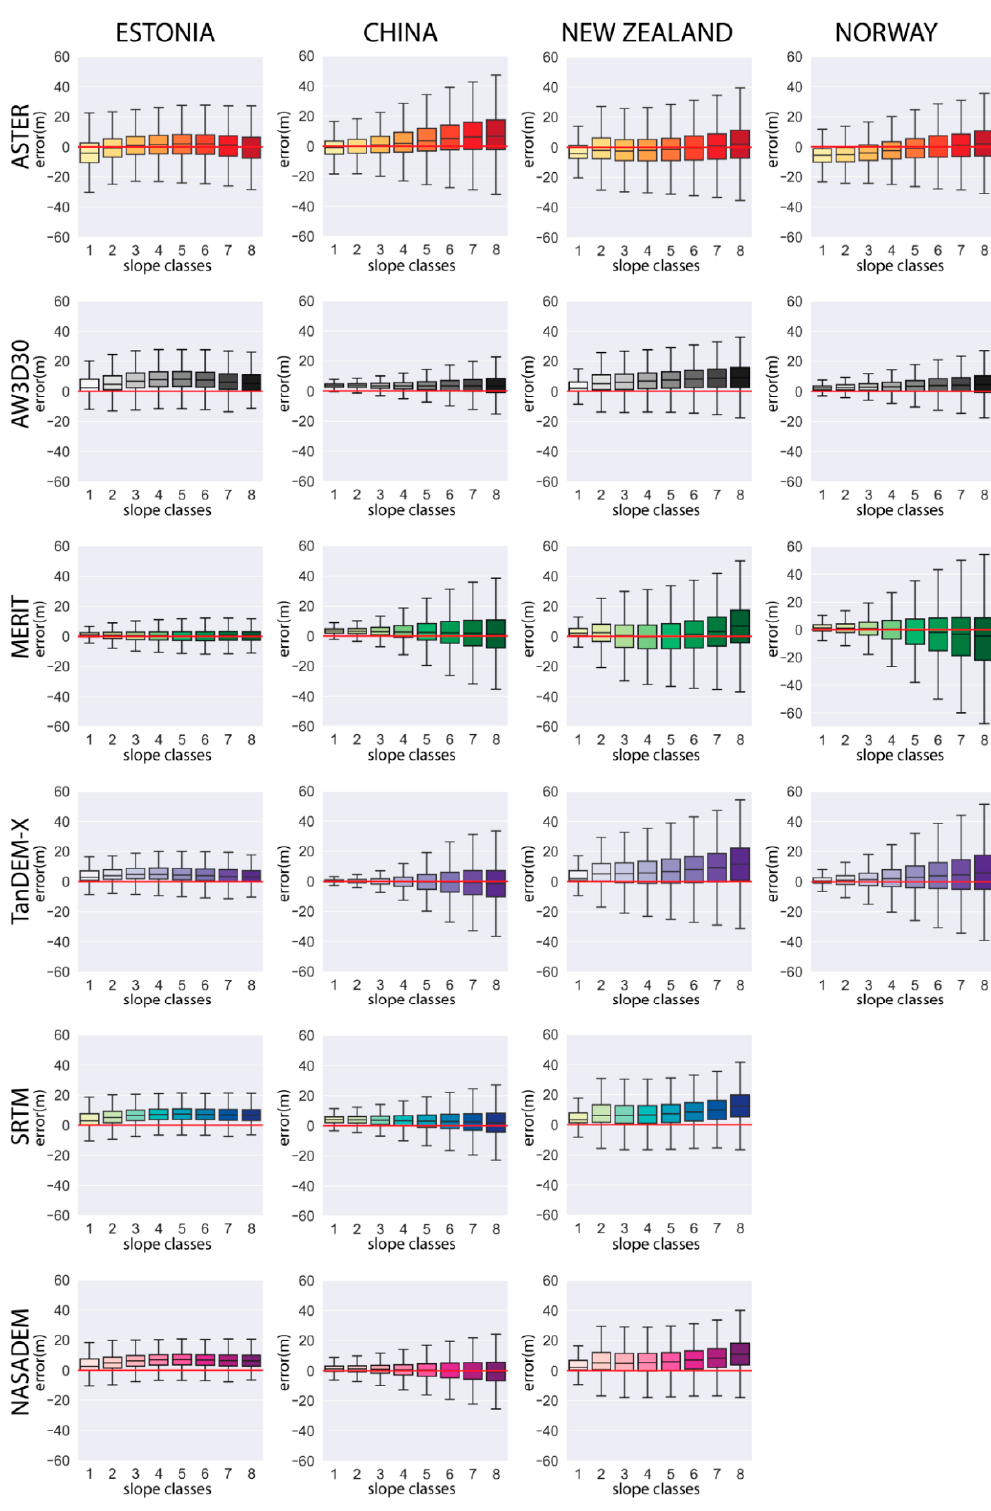
Figure 4. Box plots of errors by slope class for all global digital elevation models for the four study areas. SRTM and NASADEM data were not available for the Norwegian study area because of its high latitude. The central horizontal line in the box marks the median; the boxes show the interquartile range (25th to 75th percentile), and the whiskers show 1.5 times the interquartile range. Slope class values: 1, 0–5°; 2, 5–10°; 3, 10–15°; 4, 15–20°; 5, 20–25°; 6, 25–30°; 7, 30–35°; 8, >35°.